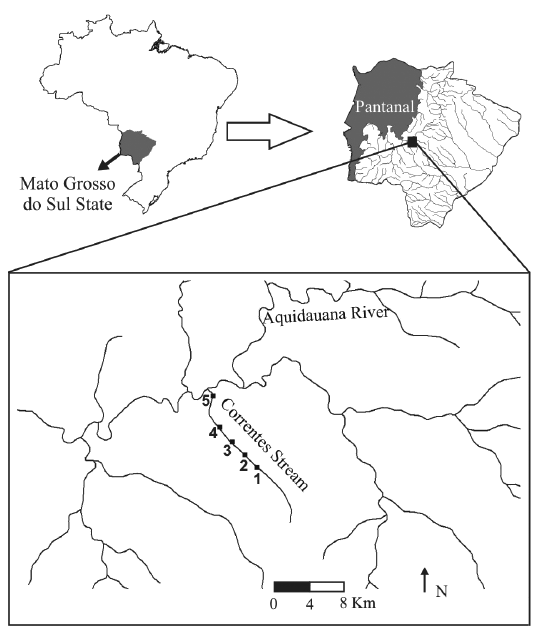
Fig. 1. Map showing localization of the sampled reaches of Correntes stream in the plateau region of the Paraguay basin, Mato Grosso do Sul State,